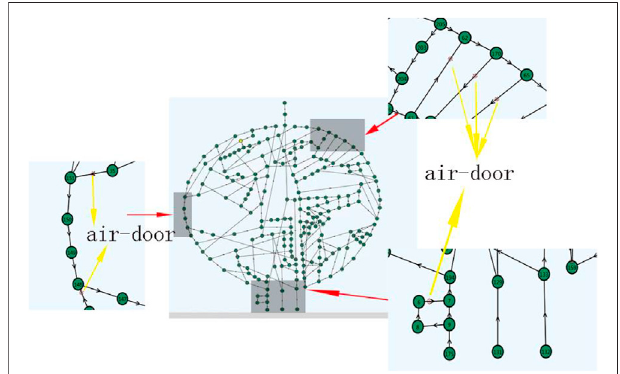
FIGURE 7 | Ventilation system network of Wangjialing